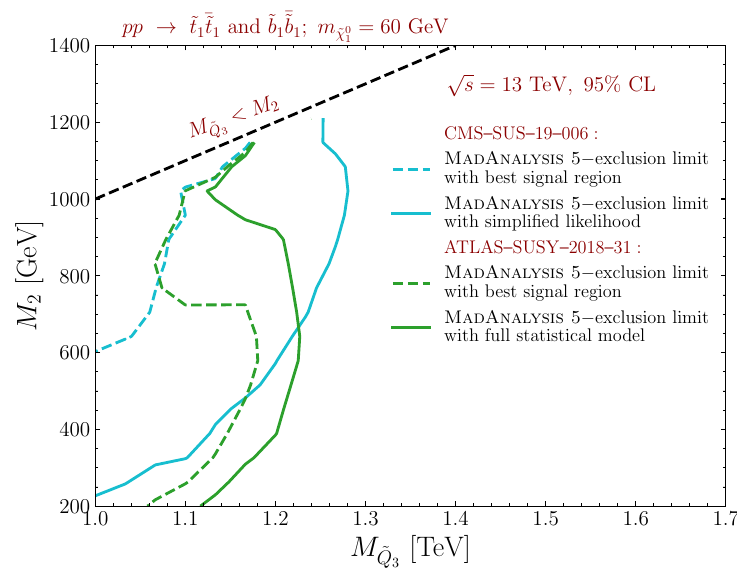
Figure 11: 95% confidence level exclusion limits on T6MSSM scenario in the plane of stop / sbottom versus wino mass parameters ( m ˜ = M = 60 GeV). The results for ATLAS-SUSY-2018-31 are in green, the results m 1 ˜ χ 0 1 for CMS-SUS-19-006 in blue. Full lines are the limits with, dashed lines without SR combination.